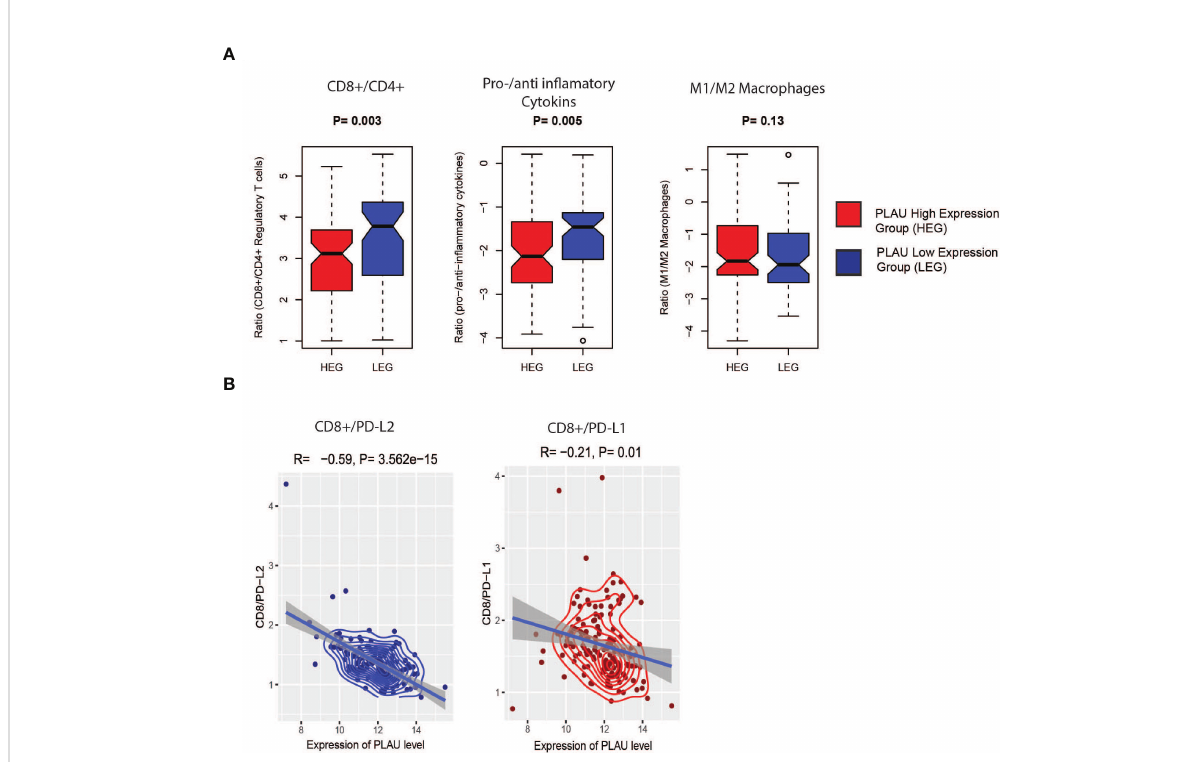
FIGURE 10 Association of PLAU upregulation with the immune ratios in the TCGA PDAC cohort. (A) CD8+ T cells/CD4+ T cell (P= 0.003) and pro-/anti- in fl ammatory cytokines (P= 0.005), signi fi cantly lower in the high expression group (HEG) of PLAU and (B) , the PLAU expression is negatively correlated with CD8A/PD-L1 (Pearson ’ s correlation R=-0.59, P= 3.562e-15) and CD8A/PD-L2 (Pearson ’ s correlation R=-0.21, P=